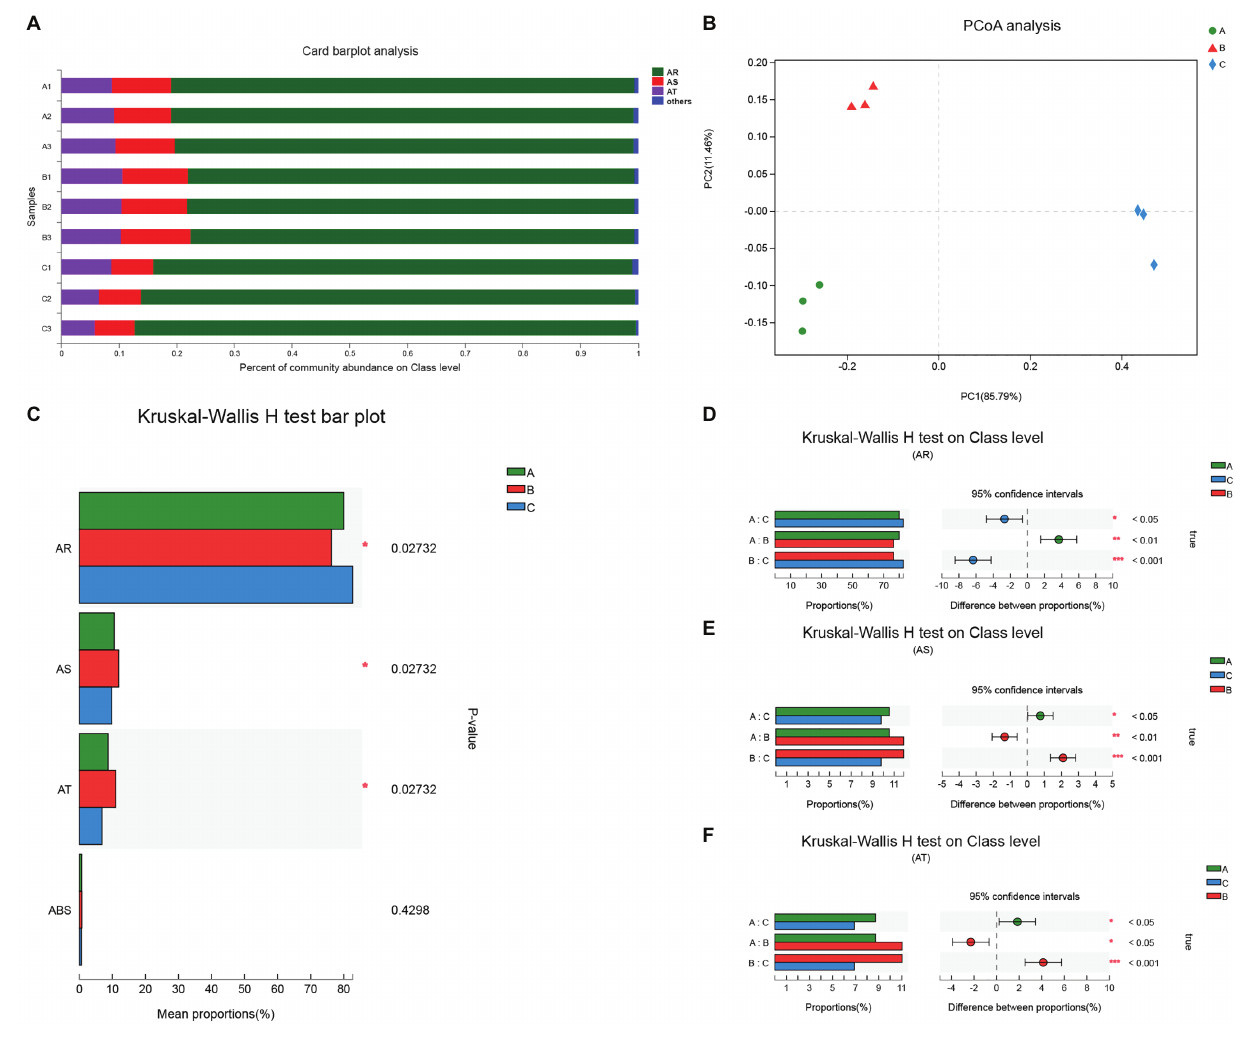
FIGURE 4 | Community abundance of total ARGs and statistical comparison on class type level. (A) Percentage of community abundance on antibiotic class type level; (B) PCoA analysis of community on antibiotic type level; (C) The difference of proportions of ARGs on class level compared in three groups; (D) The composition difference of ARGs in pairwise comparison; (E) The composition difference of antibiotic sensitive (AS) genes in pairwise comparison; and (F) The composition difference of antibiotic target (AT) genes in pairwise comparison. Differences were considered statistically significant at * p < 0.05; ** p < 0.01; and *** p < 0.001